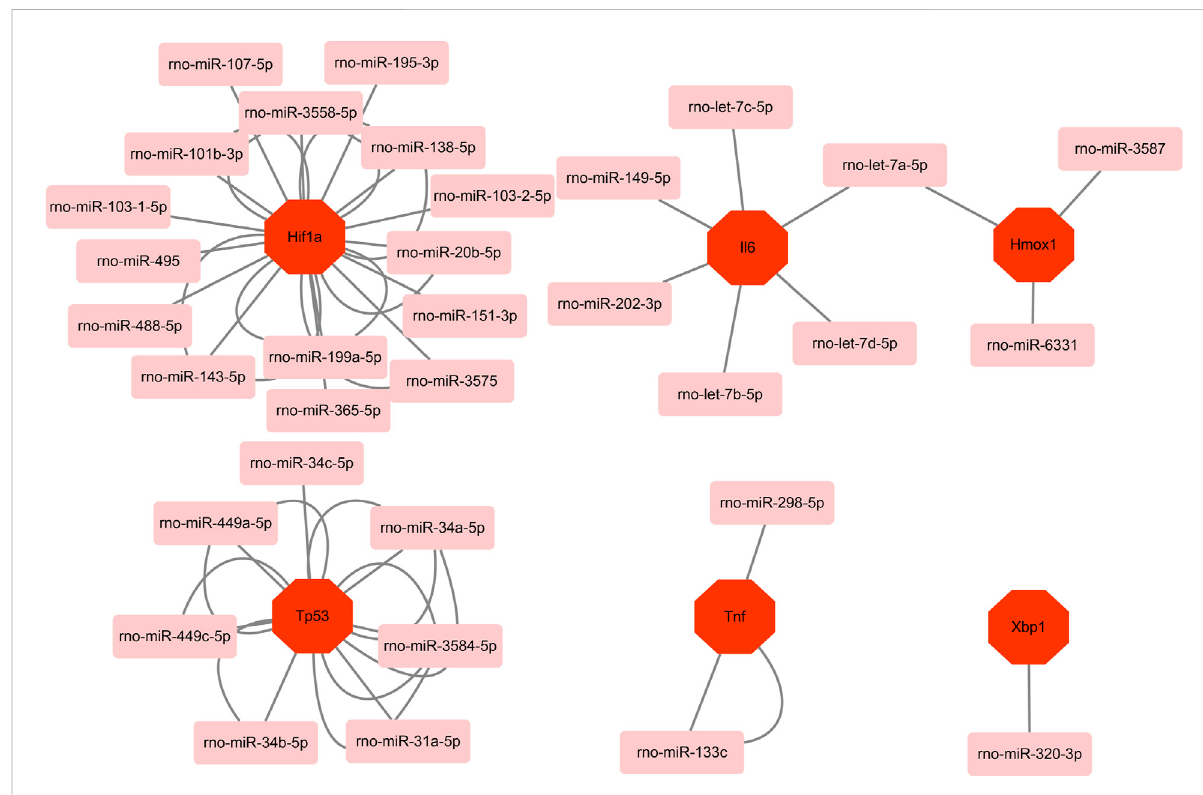
FIGURE 7 Based on the miRWalk database, mRNA – miRNA regulation network of hub genes was constructed using Metascape.